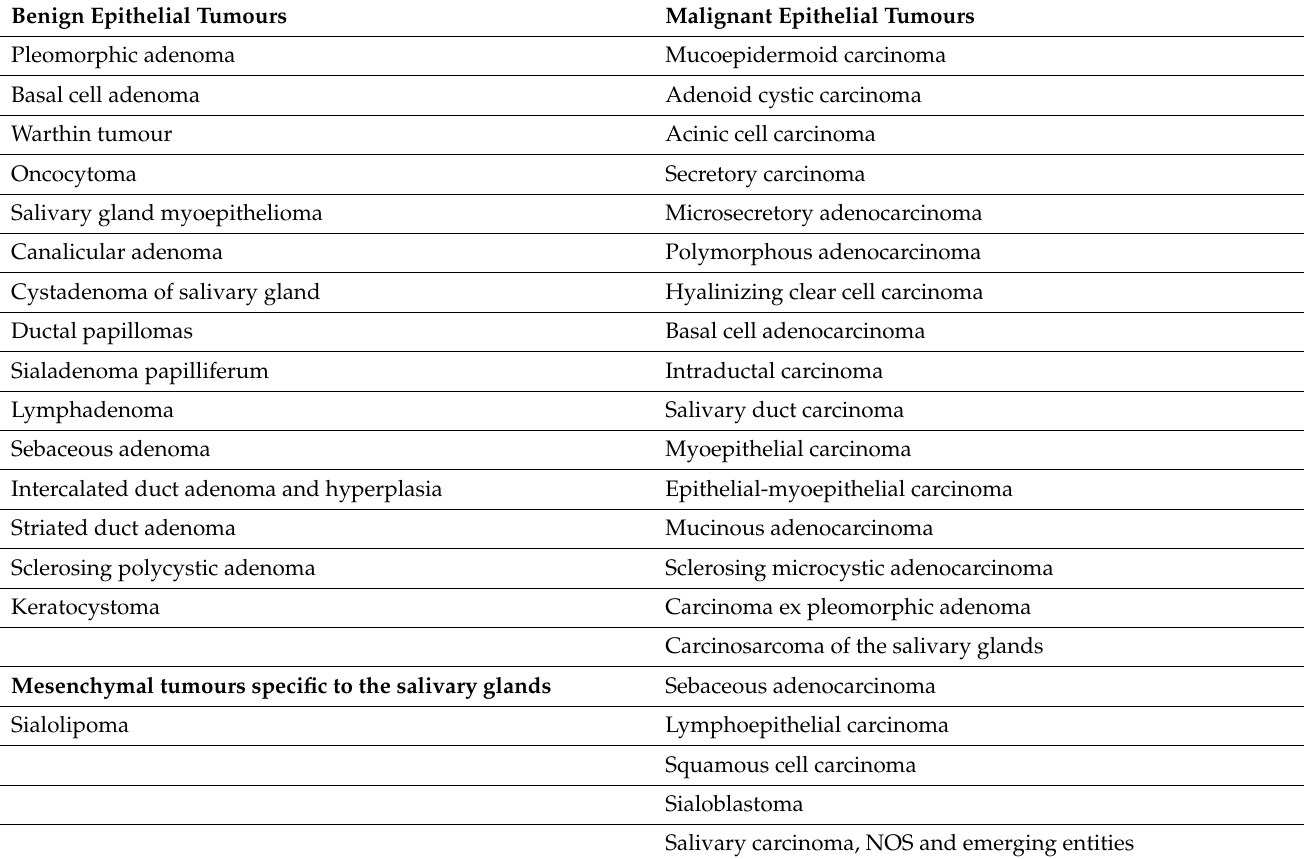
Table 1. WHO Classification of Head and Neck Tumors: Salivary Glands (5th